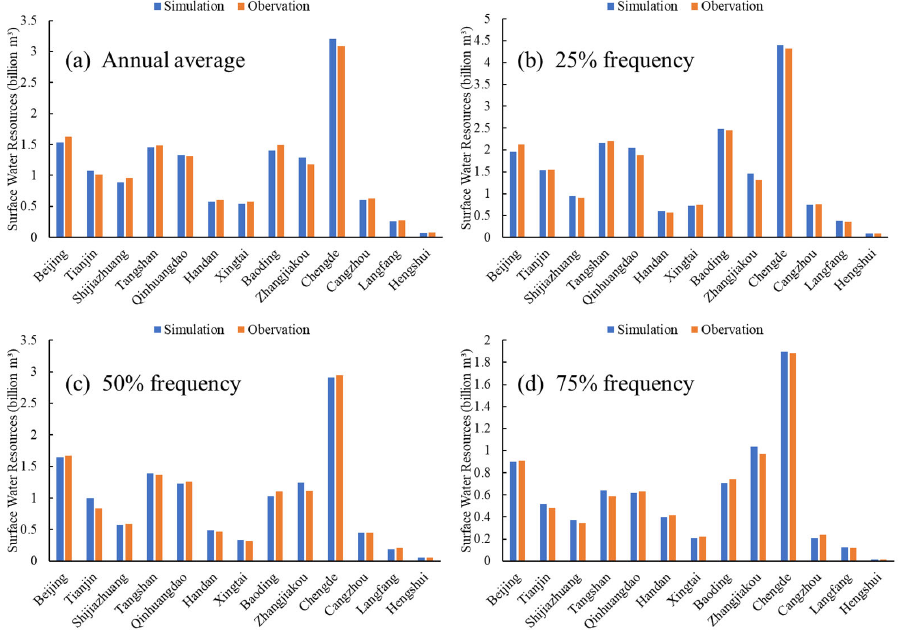
Figure 7. Comparison of simulated and observed surface water resources under different characteristic frequencies for different cities.